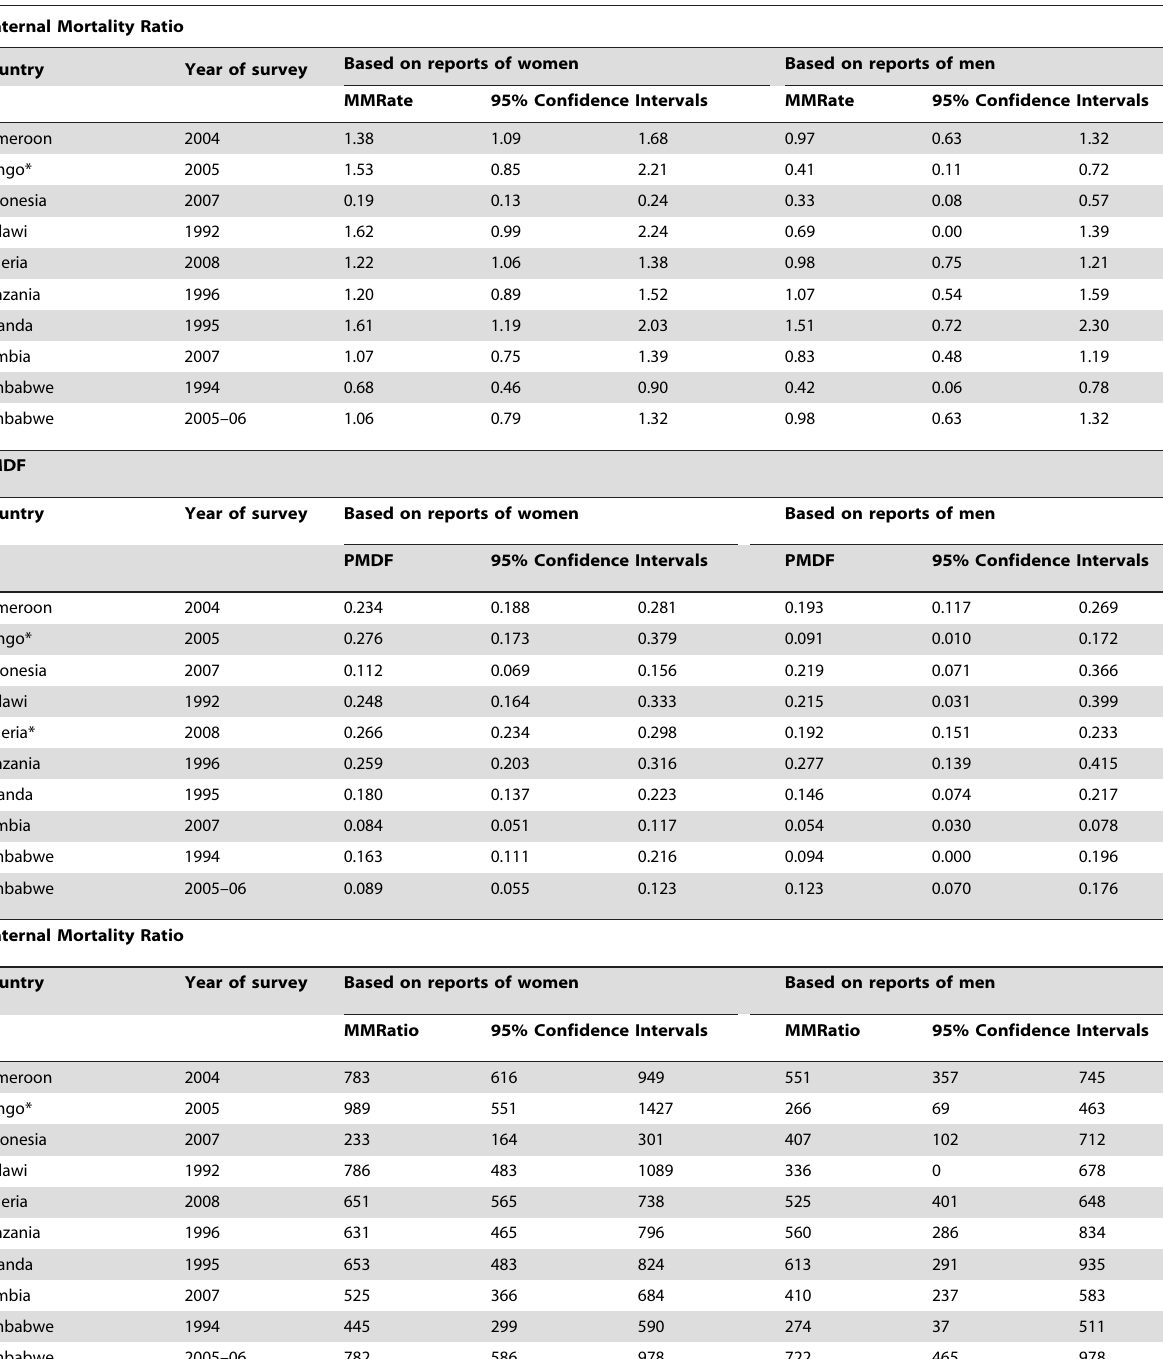
Table 2. Age-standardized maternal mortality rates (MMRates), proportions of maternal deaths among deaths of females of reproductive age (PMDFs) and maternal mortality ratios (MMRatios) obtained from sibling histories reported by women and men for the 1–5 calendar years preceding the